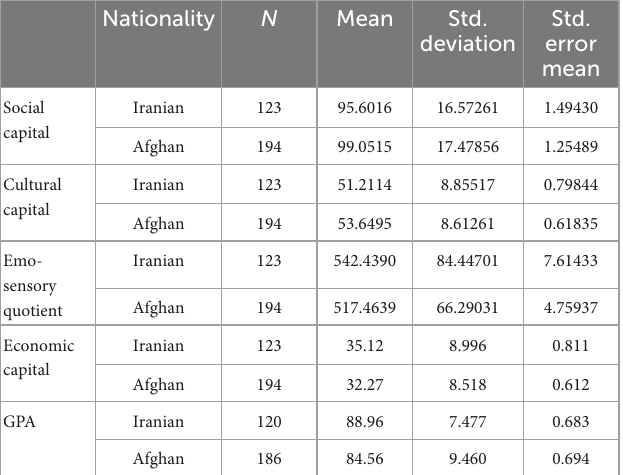
TABLE 3 Descriptive statistics of the Iranian and Afghan